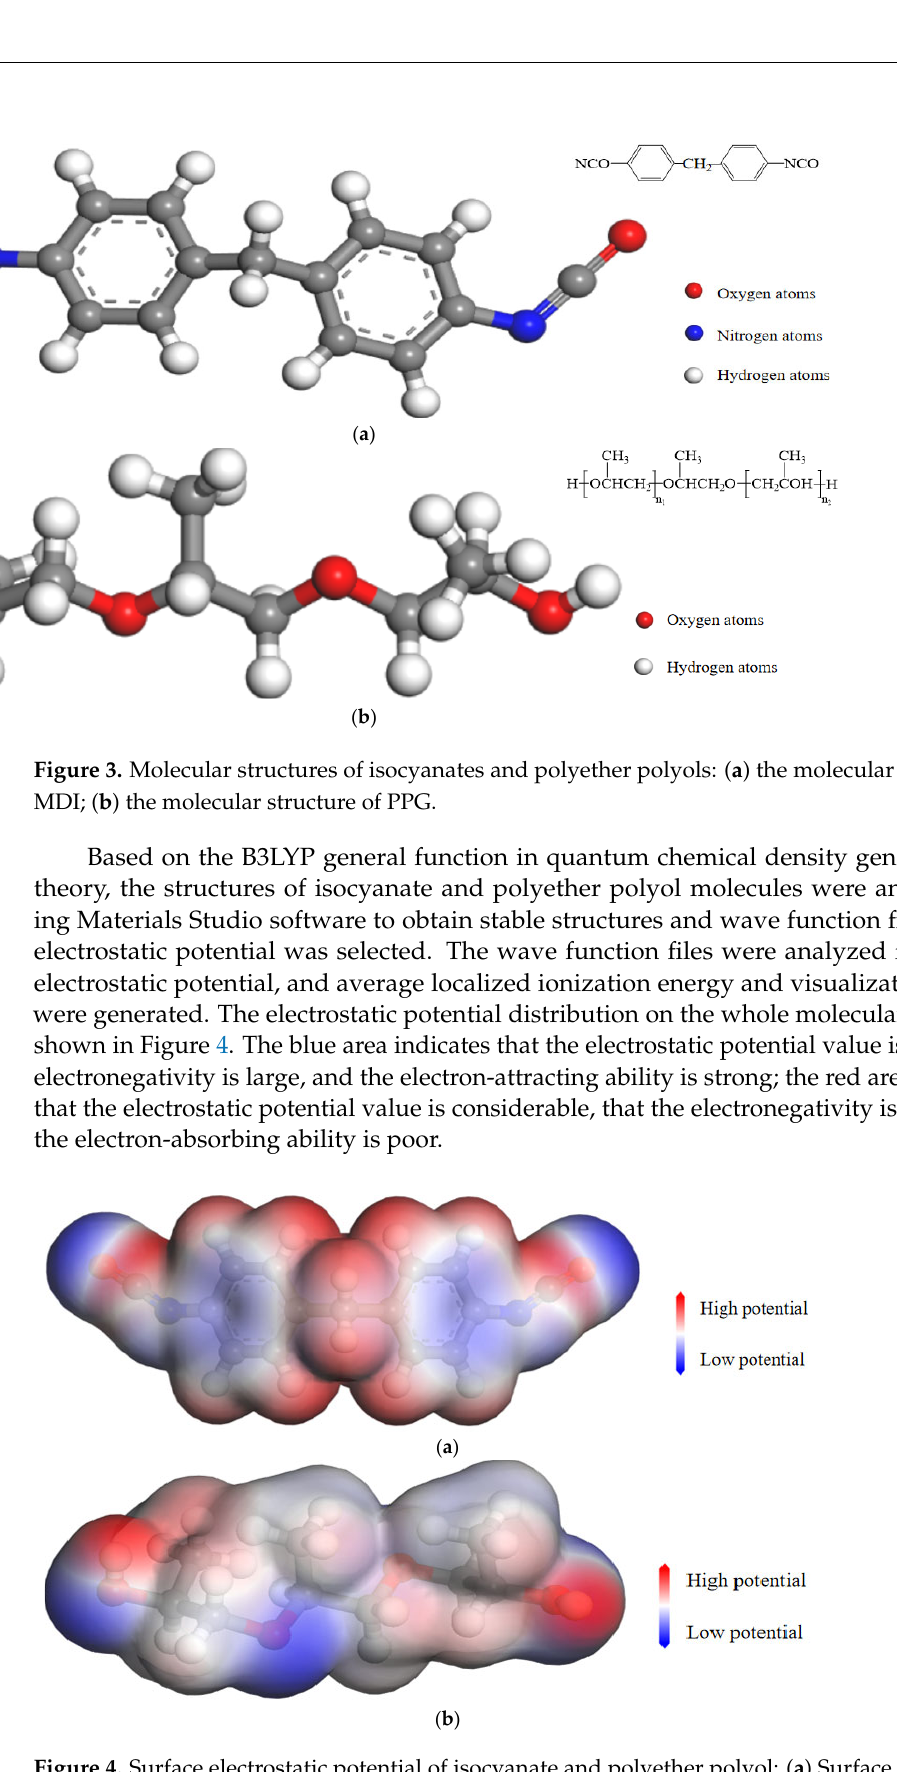
Figure 5. Polyurethane polymerization process. The isocyanate group is highly reactive and also reacts with the hydroxyl group ( ‐ OH) of water molecules to generate a large amount of carbon dioxide gas and substituted urea. This reaction process is shown in Figure 6.